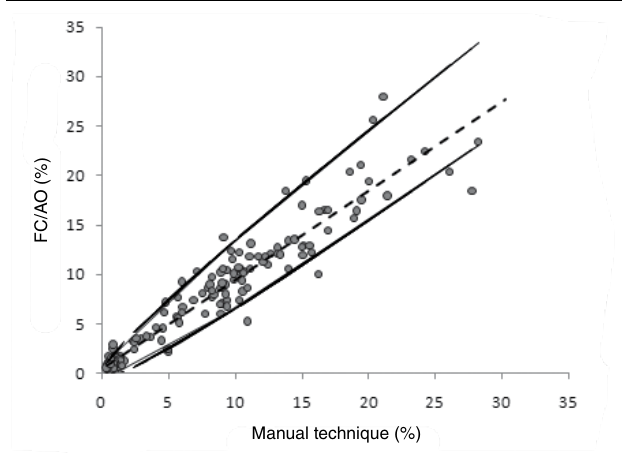
figurE 2 – Reticulocyte count (%) by the manual method and by the new CF protocol using AO ( n = 150). Continuous lines: 95% binominal confidence interval; dashed lines: linear regression between the analyzed methods; Y: 0.524 + 0.899X; r 2 : 0.912; r : 0.955 FC: flow cytometry; AO: acridine orange.